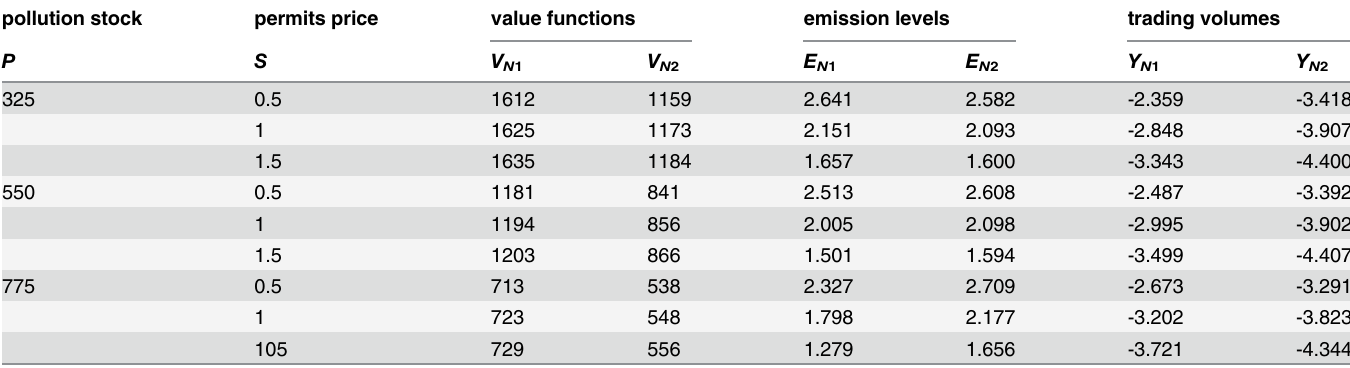
Table 2. The noncooperative game at t =